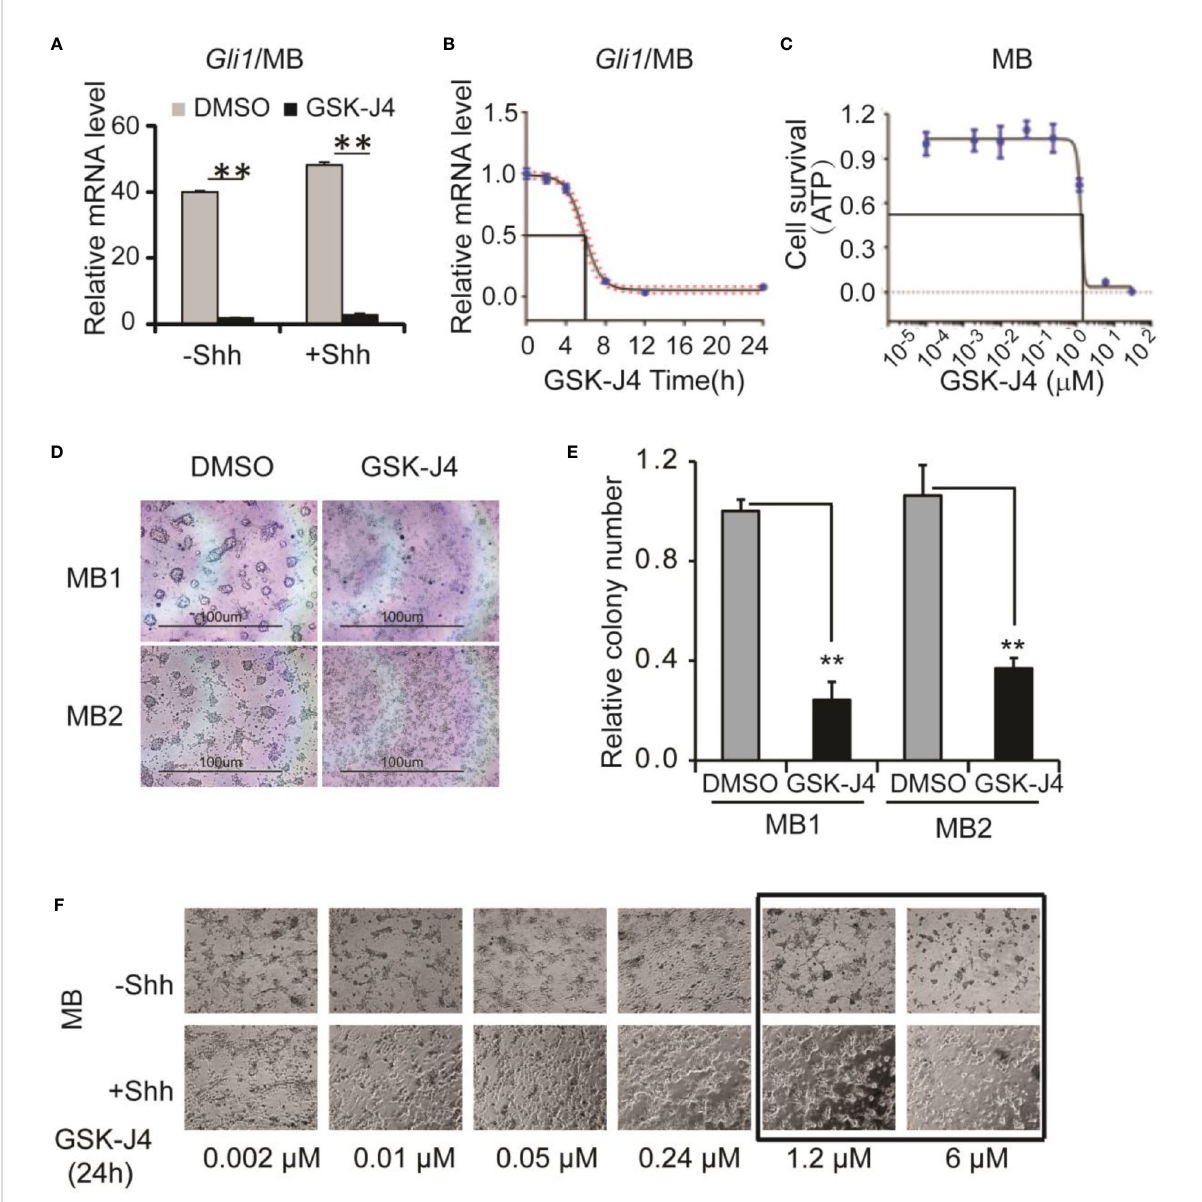
FIGURE 3 GSK-J4 shows antitumor activity in mouse primary medulloblastoma cells. (A) Shh target gene Gli1 mRNA expression is inhibited by the treatment of GSK-J4 on mouse Shh-type primary medulloblastoma cells (MB). (B) Time course of GSK-J4 effects on Gli1 expression in mouse primary medulloblastoma cells. (C) Dose dependent survival of primary medulloblastoma cells after the treatment of GSK-J4 shown by ATP assay. (D) Survival of primary medulloblastoma cells treated with GSK-J4. (E) Tumor colonies after treatment of GSK-J4. (F) Time course performances of primary medulloblastomas after the treatment of GSK-J4. The cells with frame have signi fi cant performance changes after treatment with GSK-J4. Signi fi cance determined using t -test. ** p <